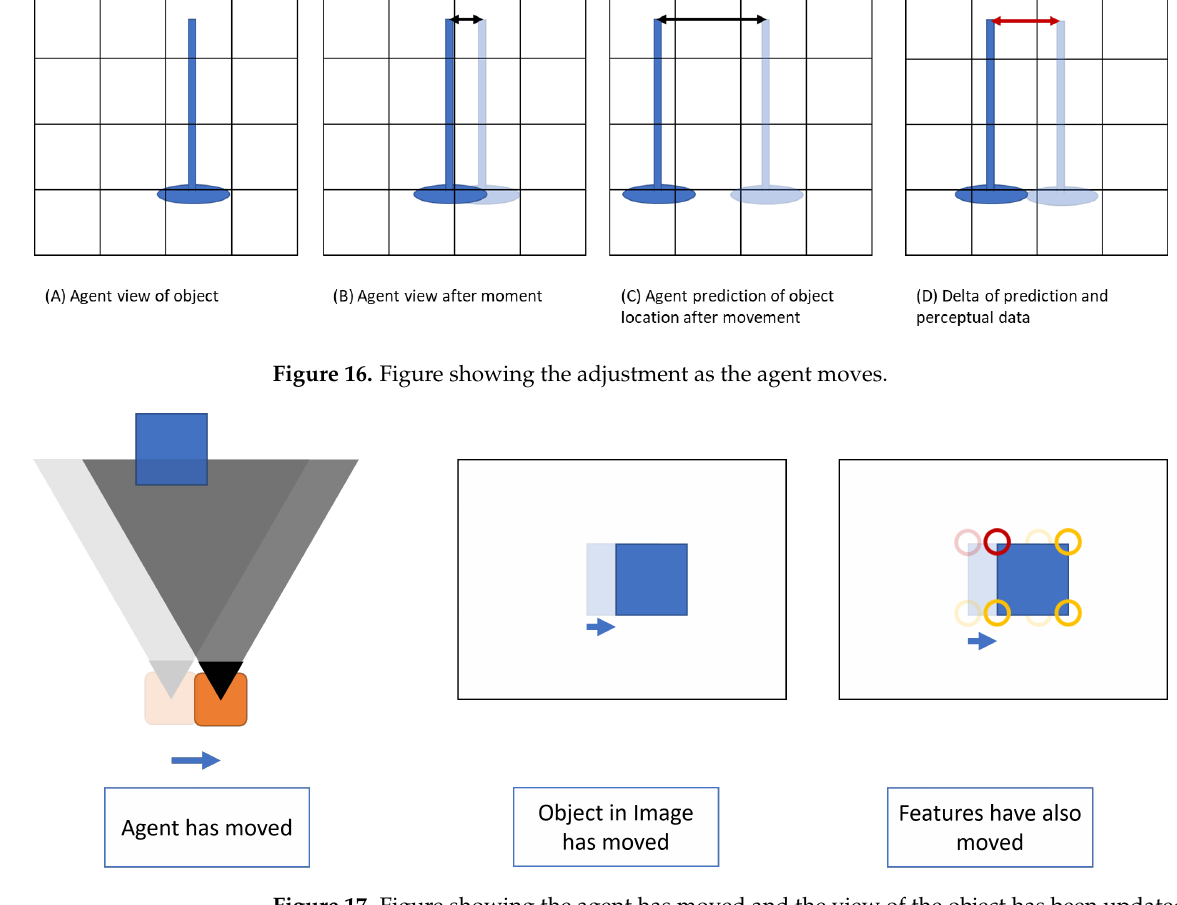
Figure 17. Figure showing the agent has moved and the view of the object has been updated.